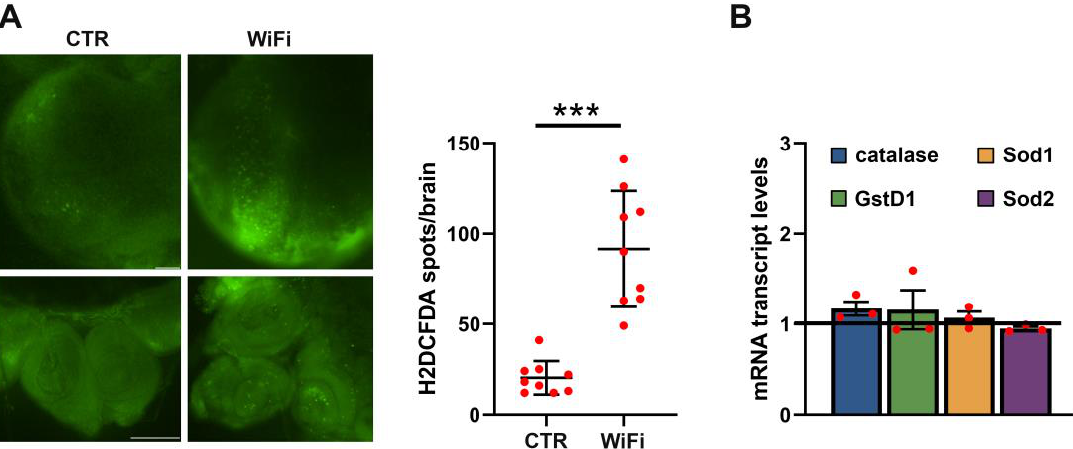
Figure 6. ( A ) Fluorescence microscope images of H2DCFDA in optic lobes (upper panels) and imaginal discs (lower panels) from control and WiFi exposed third instar larvae. The scale bar indicates 100 µ m. The scatter plot indicates the quantitative analysis of H2DCFDA positive puncta. Data are the means ± SEM. The dots indicate individual data points across three independent biological replicates (*** p ≤ 0.01; Unpaired t test). ( B ) qRT-PCR analysis of ROS-related genes in control and WiFi-exposed larval brains. Transcript levels were normalized to rp49 and displayed as fold change relative to the unexposed controls. Bar graph represents the mean ± SEM from at least two independent experiments. Red dots indicate individual data points. The black horizontal line indicates the fold change control value, set to one.